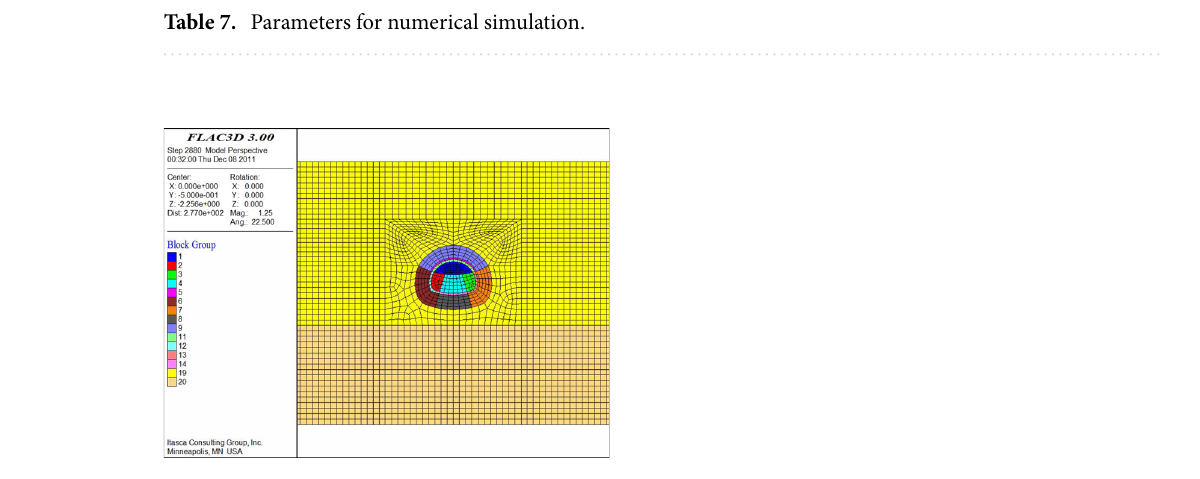
Figure 9. Numerical model of advanced support (FLAC3D 3.0 http:// docs. itasc acg. com/ flac3 d700/ flac3d/ docpr oject/ source/ flac3 dhome.